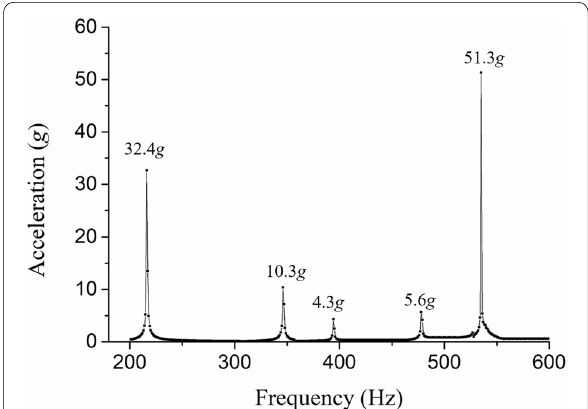
Figure 5 Acceleration frequency response curve of multi-support pipeline